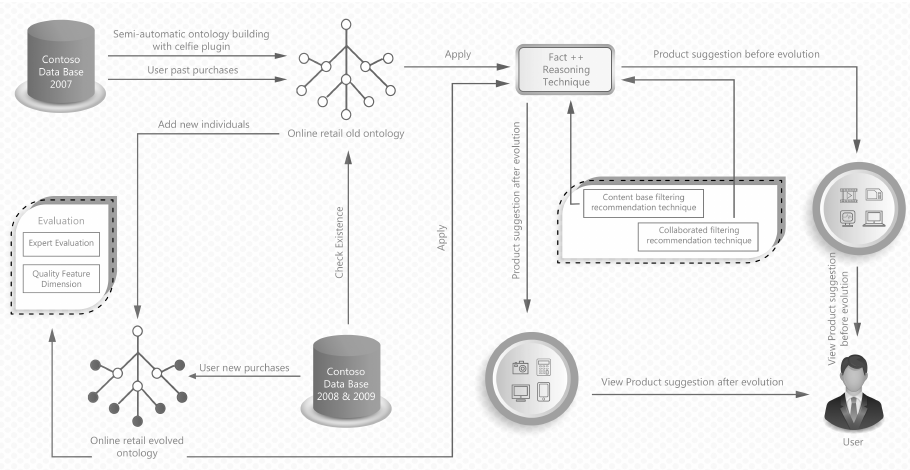
Figure 1. Proposed system architecture for recommendation based on ontology evolution.